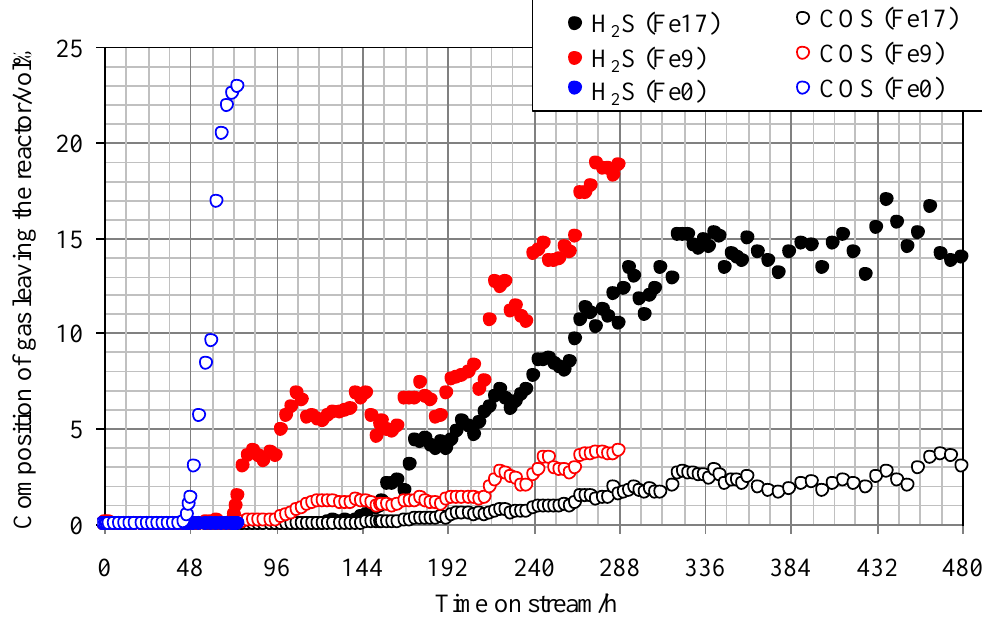
Figure 4. Breakthrough curves at 350 °C using gas containing steam. (Feed gas; CO: 37.3 vol%, H : 25.5 vol%, CH : 3.8 vol%, CO 2 4 H O: 9.1 vol%, H S: 18 ppmv, COS: 18 ppmv), SV(350 °C) = 1751 h −1 2 2